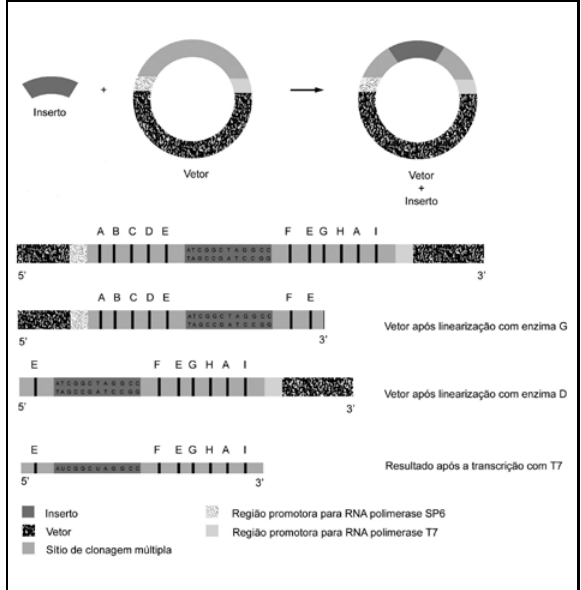
Figura 1 – Diagrama esquematizando as principais etapas de preparação da sonda. O DNA-alvo ou inserto, numa primeira etapa, é inserido no MCS de um vetor hipotético com uma região MCS e duas regiões promotoras para as RNAs polimerases Sp6 e T7. O vetor com o inserto (recombinante) é linearizado no MCS, utilizando uma enzima de restrição. Observe, no diagrama, como é possível relacionar a enzima de restrição com a enzima de polimerização e a orientação anti-senso e senso. Observe, por